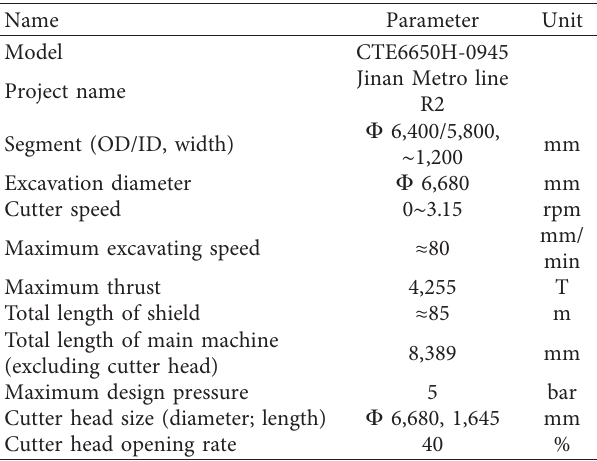
Table 1: Basic parameters of shield machine.